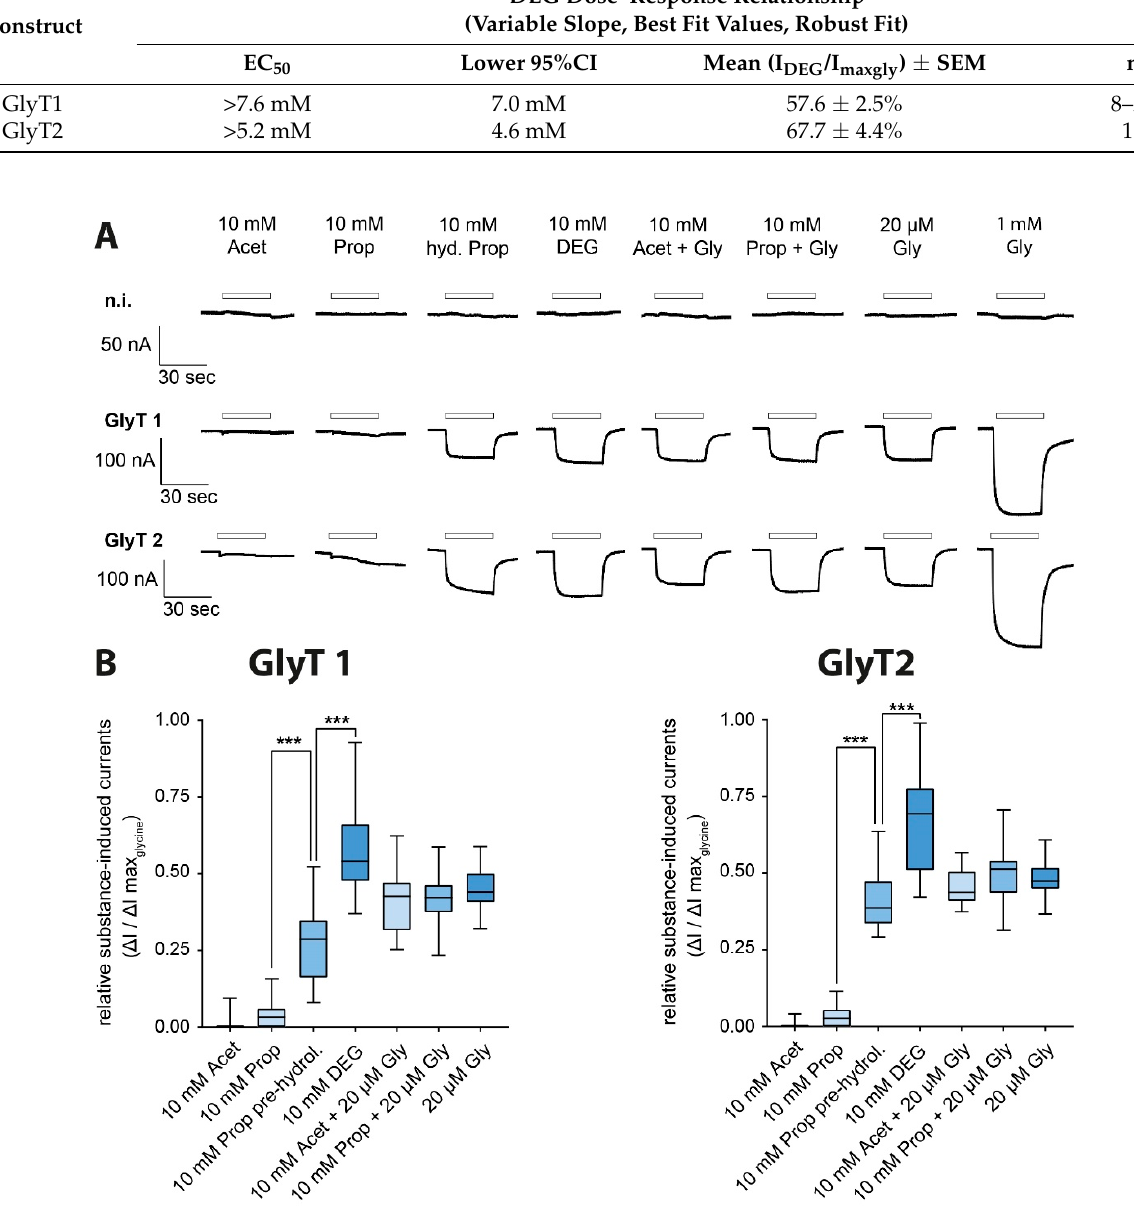
Figure 3. N , N ‐ diethylglycine ( DEG), but not propacetamol or acetaminophen, functions as an al ‐ Figure 3. N , N -diethylglycine (DEG), but not propacetamol or acetaminophen, functions as an alternative substrate on GlyT1 ternative substrate on GlyT1 and GlyT2. ( A ) Representative extract of original electrophysiological and GlyT2. ( A ) Representative extract of original electrophysiological traces in Xenopus laevis oocytes expressing GlyT1 traces in Xenopus laevis oocytes expressing GlyT1 and GlyT2 individually compared to a non ‐ in ‐ and GlyT2 individually compared to a non-injected oocyte after superfusion with glycine solution (20 µ M, 1 mM), DEG jected oocyte after superfusion with glycine solution (20 μ M, 1 mM), DEG (10 mM), acetamino ‐ (10 mM), acetaminophen (10 mM), propacetamol (10 mM), hydrolysed propacetamol (10 mM) and co-application with phen (10 mM), propacetamol (10 mM), hydrolysed propacetamol (10 mM) and co ‐ application with glycine (20 µ M). ( B ) Relative substance-induced currents of GlyT1 and GlyT2 in relation to the maximum observed current glycine (20 μ M). ( B ) Relative substance ‐ induced currents of GlyT1 and GlyT2 in relation to the induced by 1 mM glycine (GlyT1 n = 29–51; GlyT2 n = 13–44; data presented as boxplots, p < 0.001 (***), one-way ANOVA maximum observed current induced by 1 mM glycine (GlyT1 n = 29–51; GlyT2 n = 13–44; data with Bonferroni post-hoc presented as boxplots, p < 0.001 (***), one ‐ way ANOVA with Bonferroni post ‐ hoc correction).